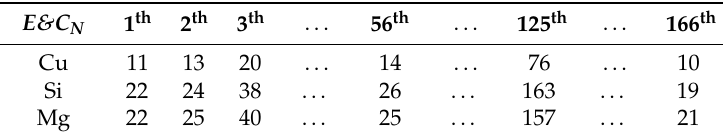
Table 3. The chemical composition of each cluster counted by IVSA